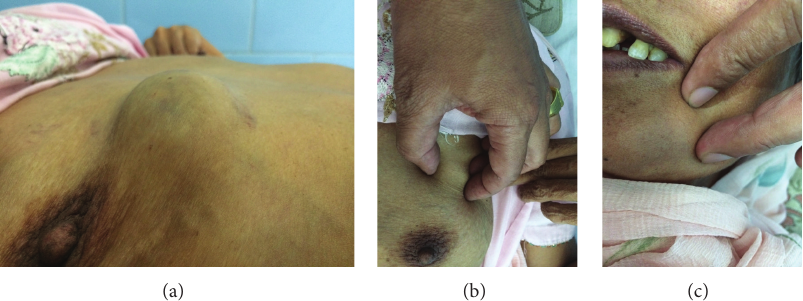
Figure 1: (a) Subcutaneous nodule seen in the anterior chest wall below the right breast. (b) Another subcutaneous nodule seen in the anterior chest wall just near the left breast. (c) Subcutaneous nodule in the mandible.